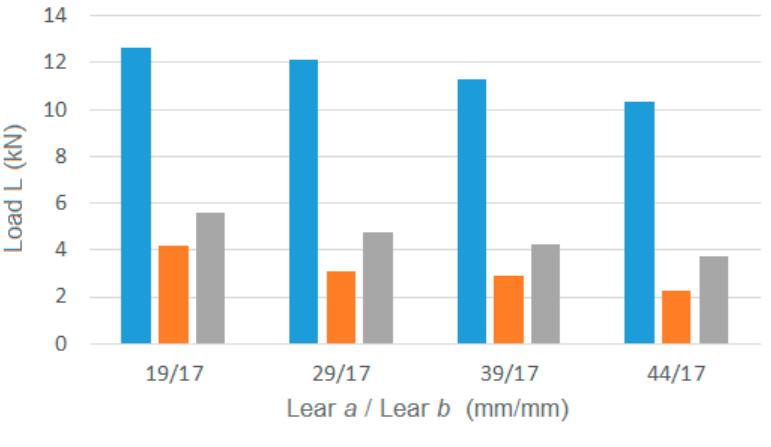
Figure 19. Graph of the maximum static load, theoretical fatigue limit and test fatigue limit for the different clamps tested.